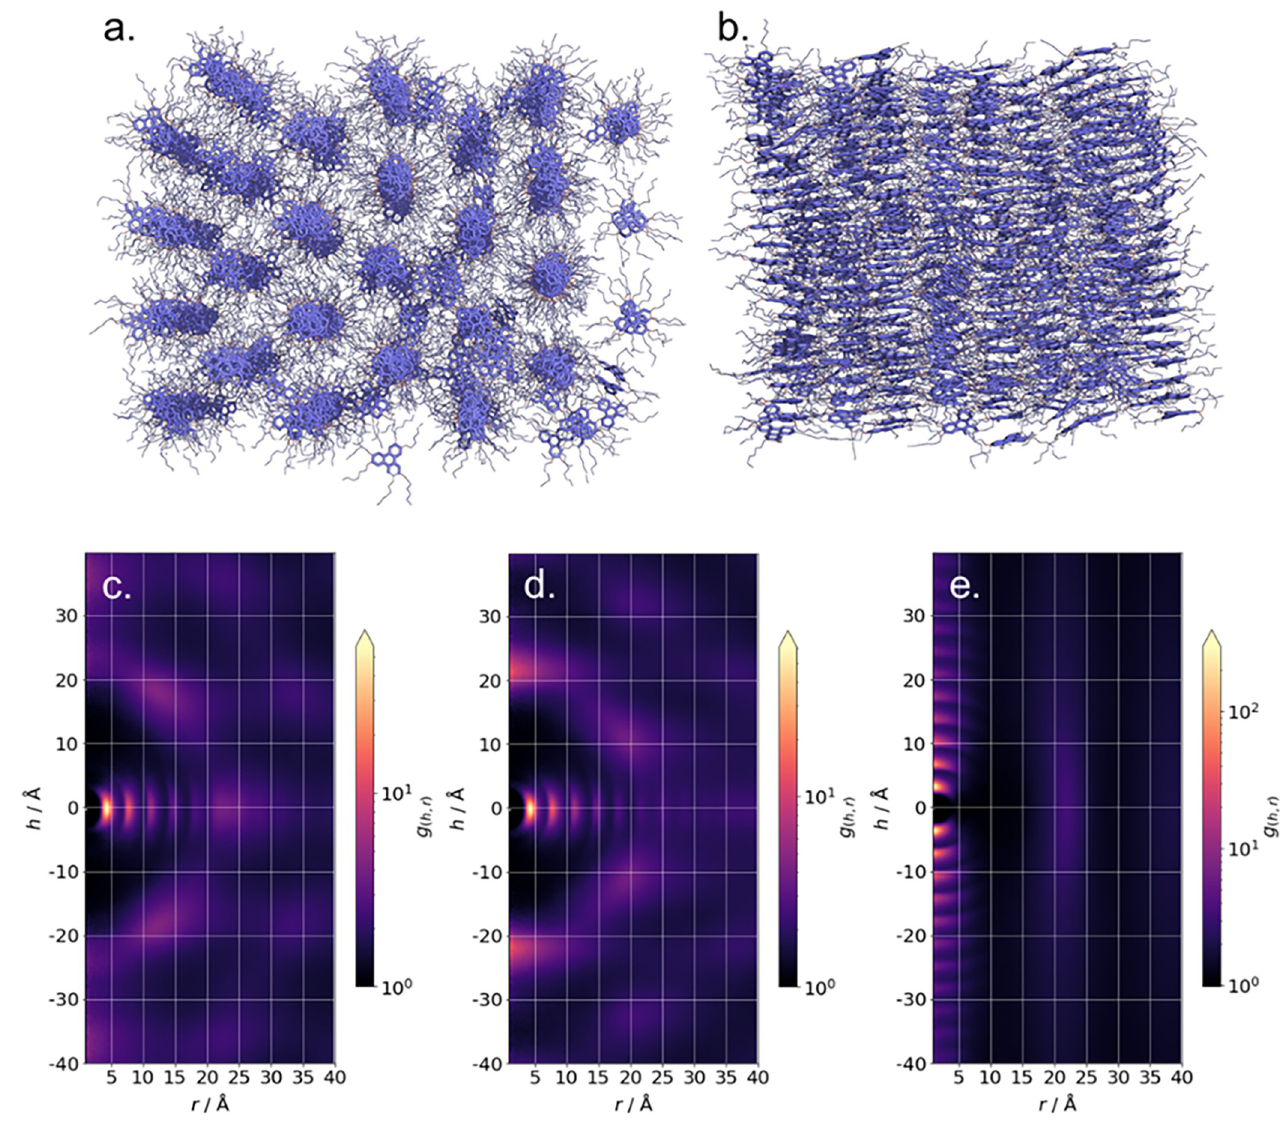
Fig 6. Instantaneous configuration of the hexagonal columnar phase formed by HAT6 at 68 ns viewed in the -xy plane (a) and -xz plane (b). Corresponding CDF plots generated using cylindr with the cylinder length oriented along the x- (c), y- (d) and z- (e) axes. Plots were generated using the following options– save no, -log yes, -ori user, -vec 1,0,0 (for c, 0,1,0 for (d), 0,0,1 for (e)).